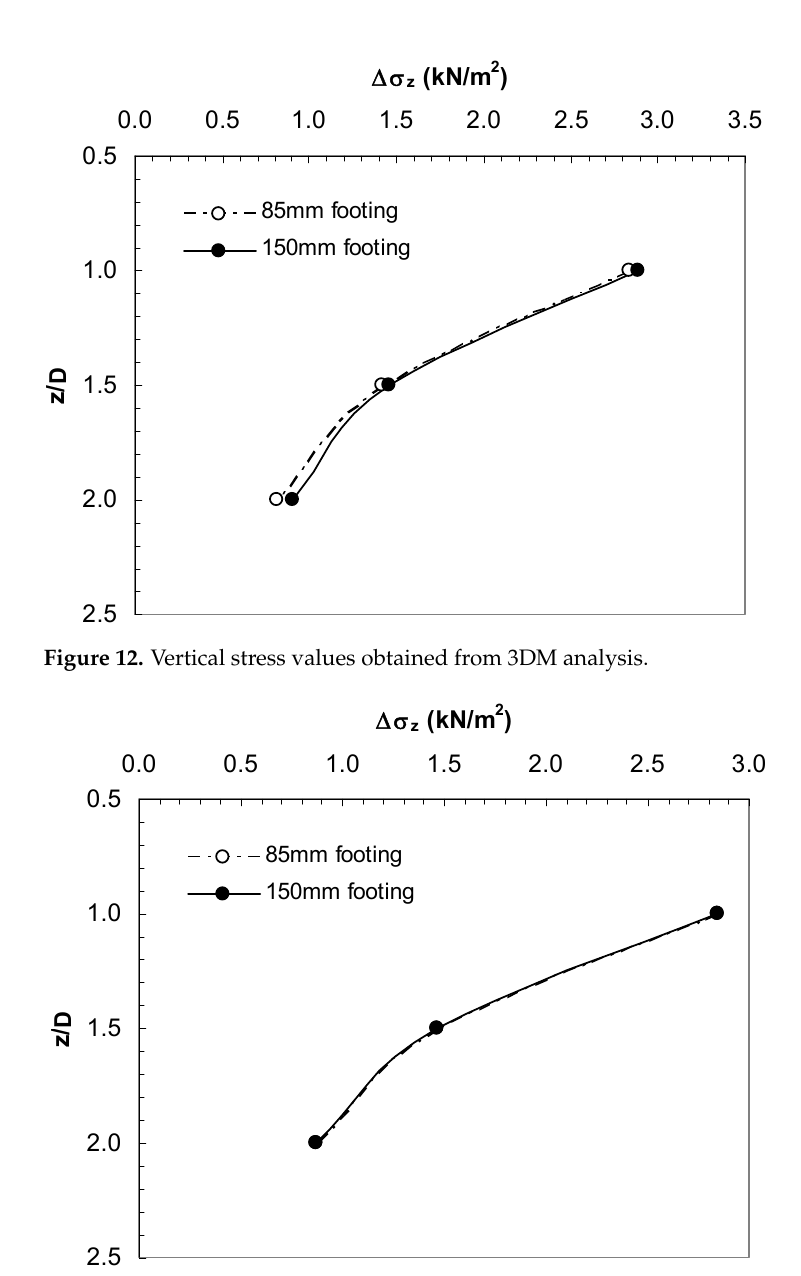
Figure 13. Vertical stress values obtained from Boussinesq theory.